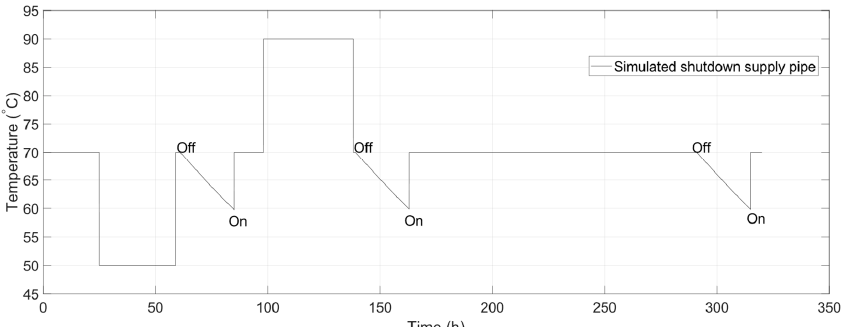
Figure 5. Illustration of the insignificant effect of recent temperature history in the supply pipe prior to a shutdown; equal temperature declines for the three shutdowns at 61–85 h, 139–163 h, and 291–315 h.